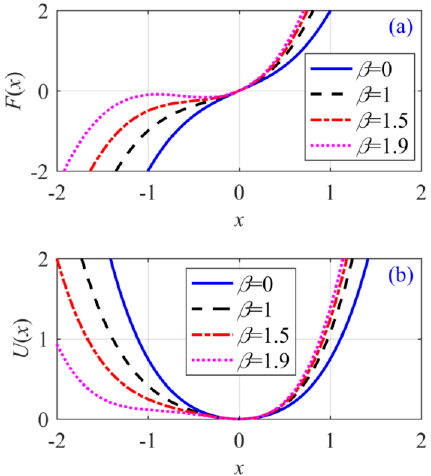
Figure 6. ( a ) Nonlinear restoring forces and ( b ) potential functions of the asymmetric MEHs for different values of quadratic coefficients.